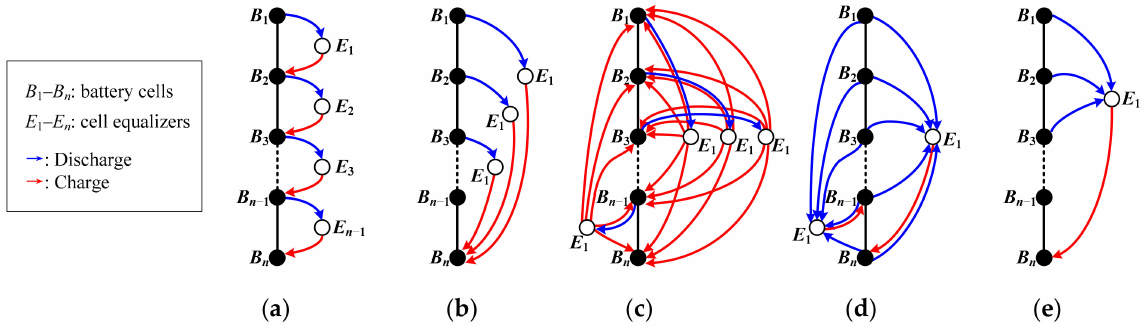
Figure 1. Balancing paths of different equalizers under the assumption that B 1 , B 2 and B 3 are equally strong, B n is weak, and other cells are balanced. ( a ) AC2C. ( b ) DC2C. ( c ) C2P. ( d ) P2C. ( e )